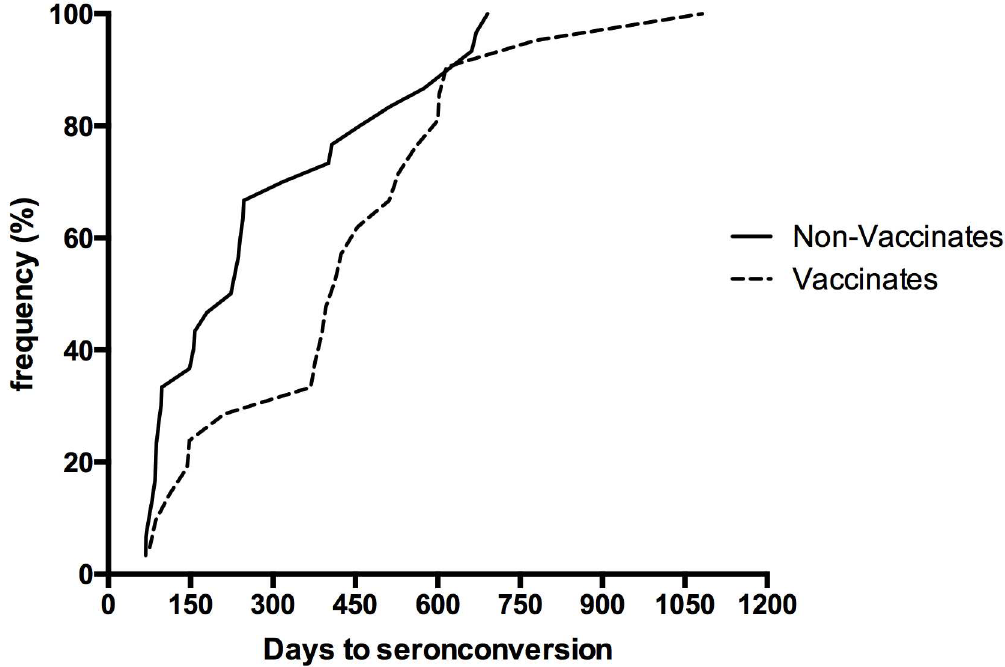
Fig 1. Time (days) to seroconversion for all badgers that seroconverted during the trial: non-vaccinated (N = 30), vaccinated (N =